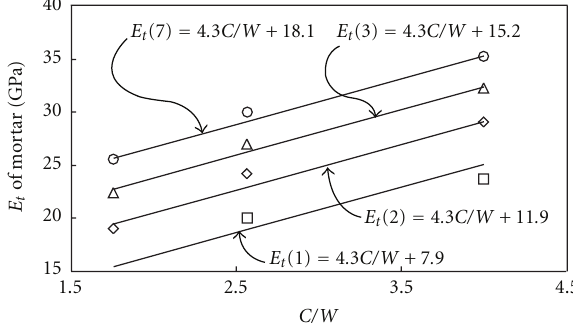
Figure 14: Relations between cement-water ratio and tensile Young’s moduli of